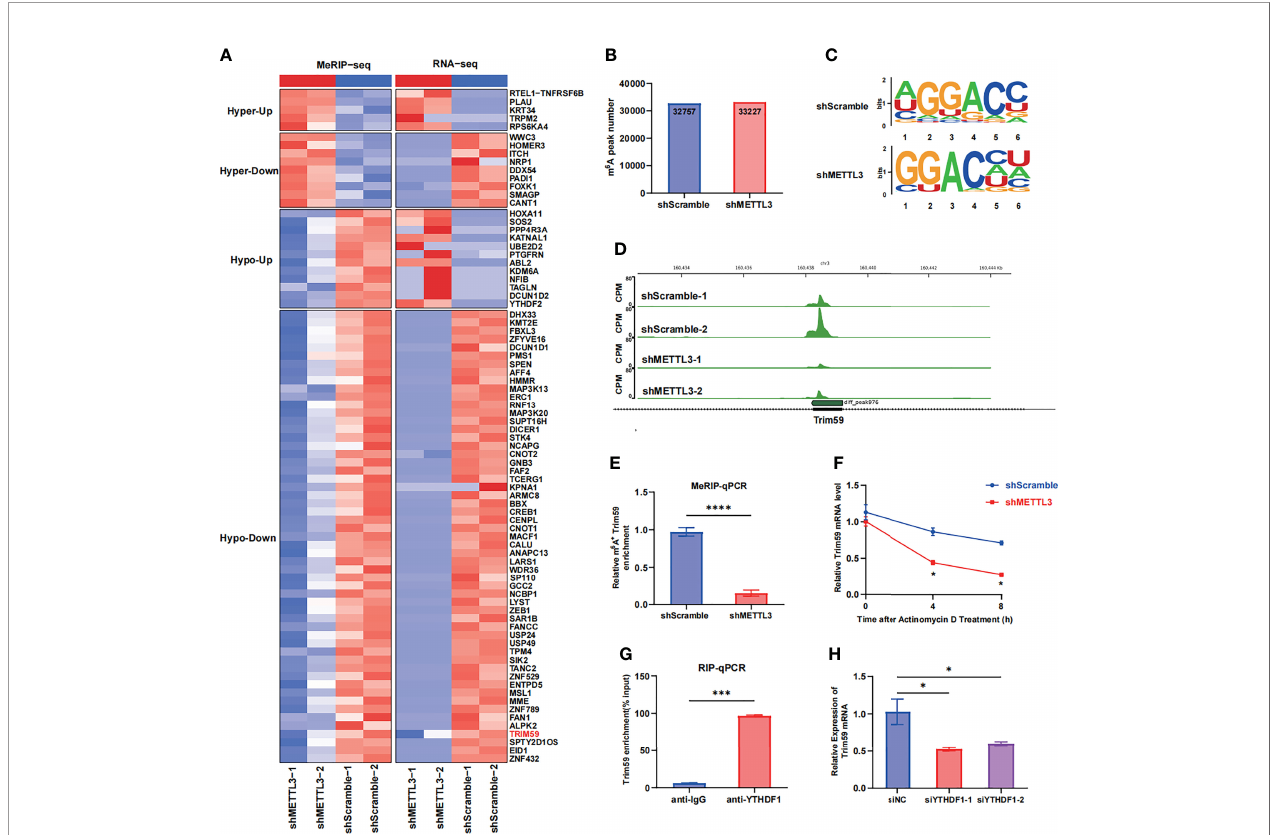
FIGURE 4 | METTL3-mediated m 6 A modi fi cation of Trim59 mRNA maintains its YTHDF1-dependent stability (A) Heatmap showing the clusters with signi fi cant changes in both the RNA expression level (RNA-seq) and m 6 A level (MeRIP-seq) in scramble and METTL3 shRNA-treated HULEC-5a cells. (B) Number of m 6 A peaks in scramble and METTL3 shRNA-treated HULEC-5a cells. (C) Global pro fi ling of m6A in HULEC-5a cells and the sequence motif identi fi ed from the top 1000 m 6 A peaks. (D) MeRIP-seq plotted the m 6 A abundances on Trim59 mRNA transcripts in HULEC-5a cells. (E) MeRIP-qPCR examined METTL3-mediated Trim59 mRNA m 6 A modi fi cations. (F) RT-qPCR analysis showing the levels of Trim59 expression in METTL3-downregulated HULEC-5a cells treated with actinomycin D (2 m g/mL) at the indicated time points. (G) RNA immunoprecipitation (RIP)-qPCR assay showing the enrichment of YTHDF1 binding to Trim59 m 6 A modi fi cation sites. (H) RT-qPCR analysis showing the levels of Trim59 expression in YTHDF1-knockdown HULEC-5a cells. All data are expressed as the mean ± SD of three independent experiments. * p < 0.05; *** p < 0.001; **** p <